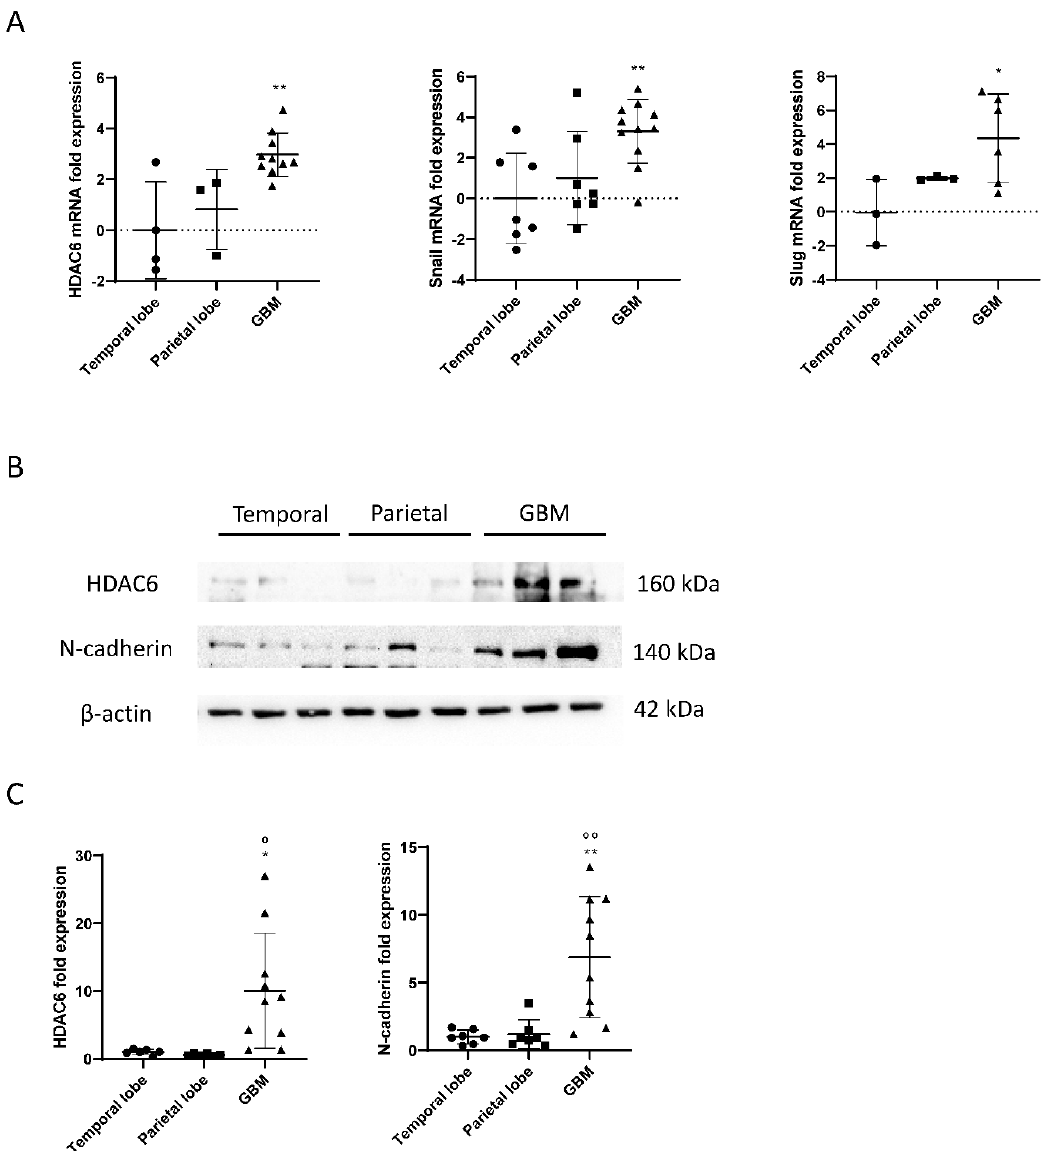
Figure 1. mRNA and protein overexpression of HDAC6 and mesenchymal markers in GBM samples. ( A ) RT-qPCR for HDAC6 and mesenchymal markers Snail and Slug in parietal and temporal lobe as well as GBM tissue. Data are represented as mean ± SD. (*) p < 0.05, (**) p < 0.01 vs. temporal lobe. (Temporal lobe: n = 7, parietal lobe: n = 7, GBM n = 11). ( B ) Western blot image for HDAC6, N-cadherin, and β -actin of control brain tissue and GBM tissue. ( C ) Analysis of western blot. Data are represented as mean ± SD. (*) p < 0.05, (**) p < 0.01 vs. temporal lobe, ( ⁰ ) p < 0.05, ( ⁰⁰ ) p < 0.01 vs. parietal lobe (temporal lobe: n = 7, parietal lobe: n = 7, GBM n = 10).